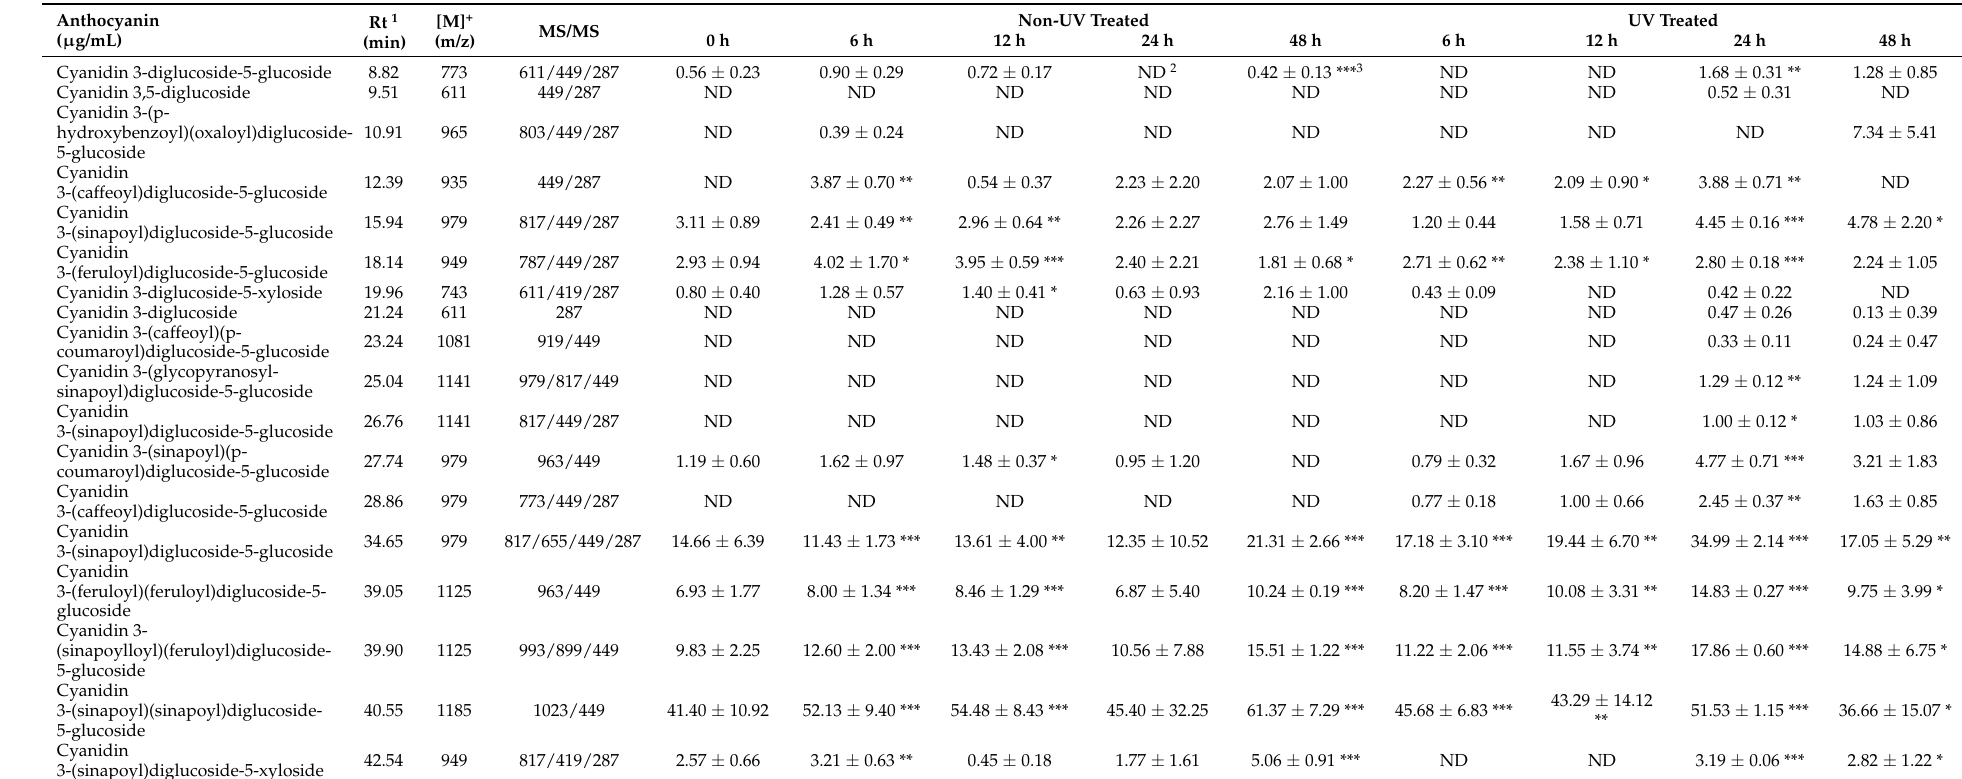
Table 1. Quantitative analysis of anthocyanin in UVB-treated purple kohlrabi